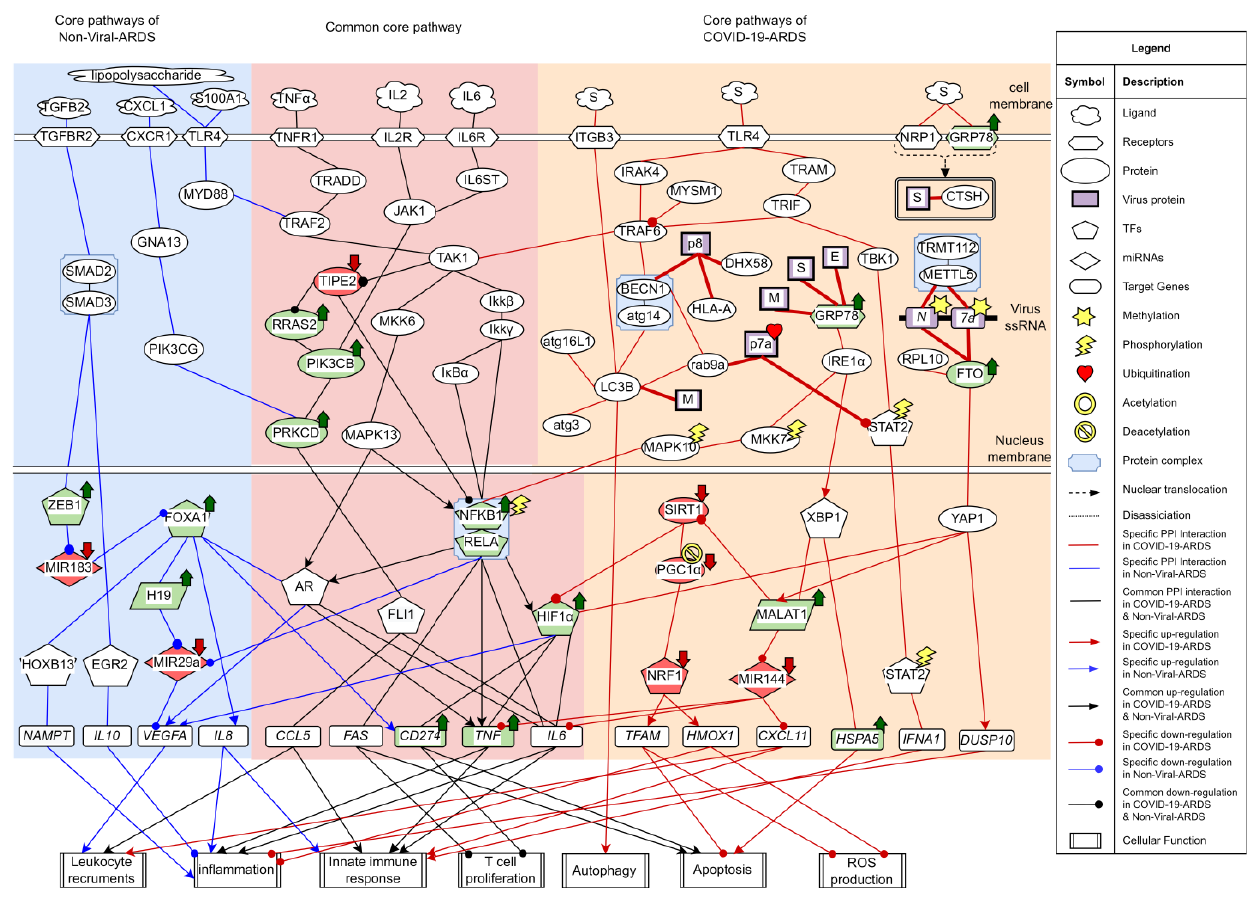
Figure 4. The common and specific core signaling pathways between COVID-19-associated ARDS and non-viral ARDS. This figure summarizes the genetic and epigenetic progression mechanism of COVID-19-associated ARDS and non-viral ARDS. The blue color background covers specific signaling pathways in non-viral ARDS. Overlapping core signaling pathways of COVID-19-associated ARDS and non-viral ARDS, namely common core signaling pathways, are covered in pink background. The skin color background covers specific signaling pathways in COVID-19-associated ARDS. The arrowheads in circle shapes indicate downregulation. The arrowheads in triangular shapes indicate upregulation. The solid lines indicate protein – protein interaction. The green nodes indicate high expression of protein/gene. The red nodes indicate low expression of protein/gene.